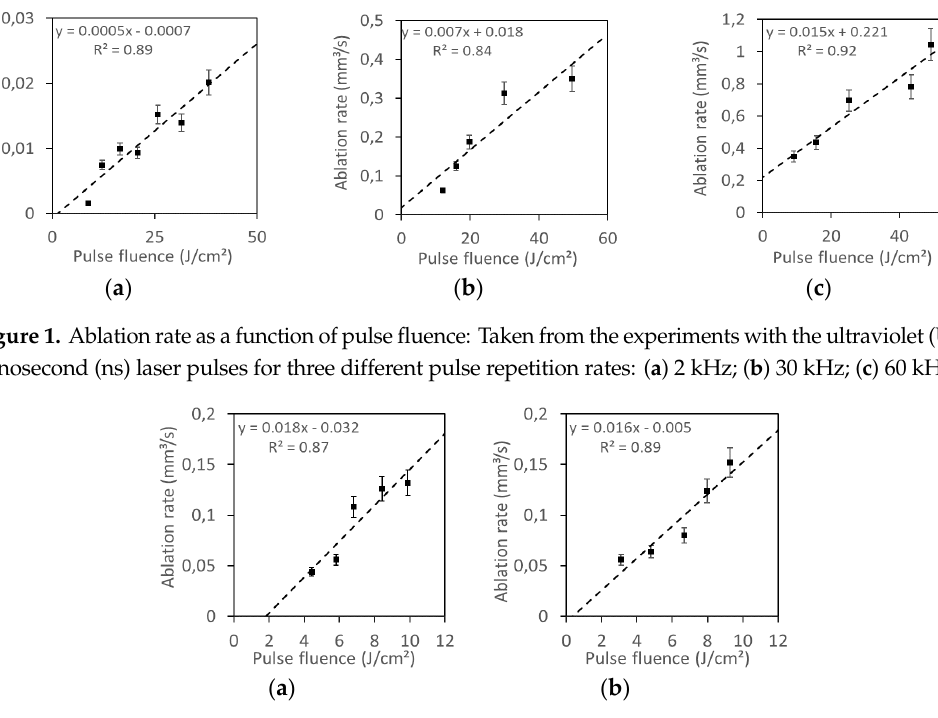
Figure 2. Ablation rate as a function of the pulse fluence from the experiments with the infrared (IR) picosecond (ps) laser pulses for two different pulse repetition rates: ( a ) 100 kHz; ( b ) 600 kHz.